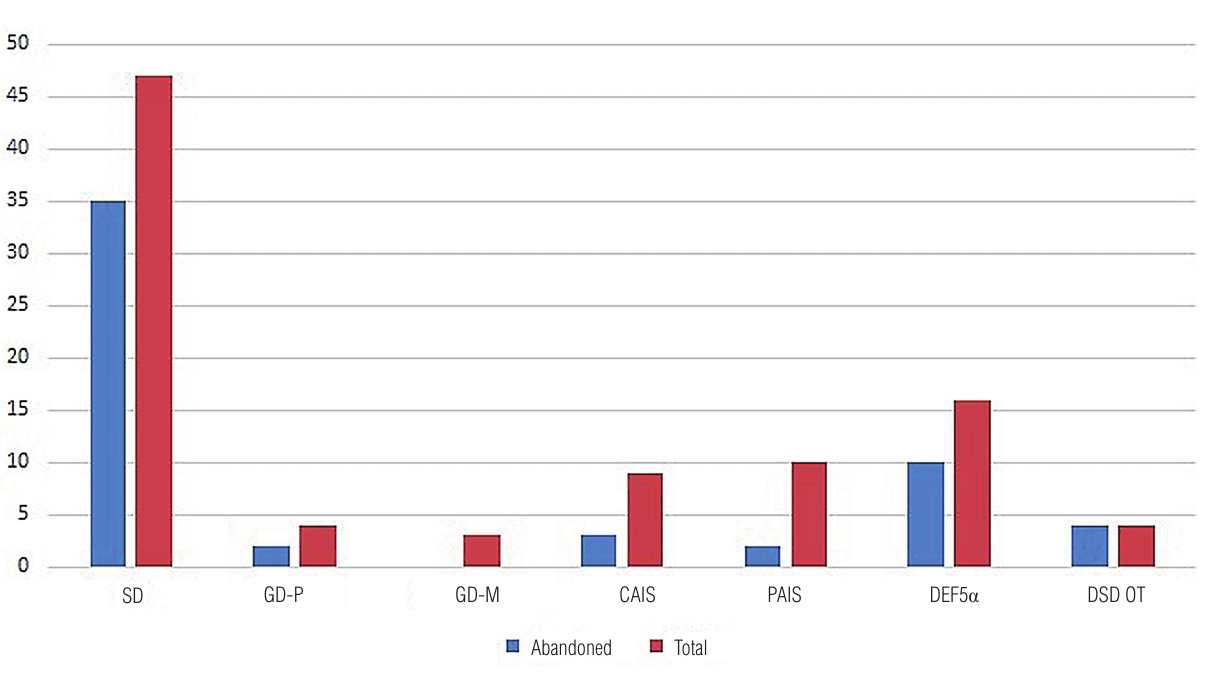
figure 1 - Distribution of patients by diagnosis DsD 46, XY